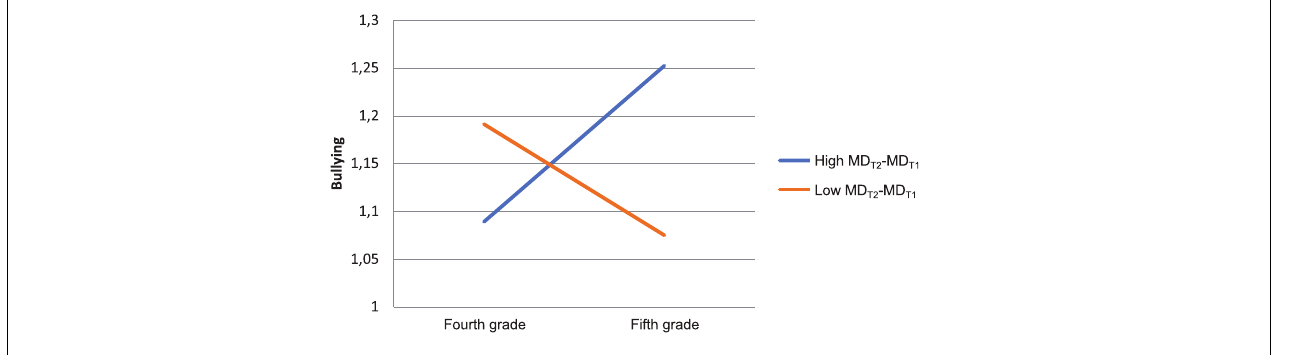
FIGURE 1 | Interaction effect on bullying change: Individual moral disengagement (MD) change × grade.